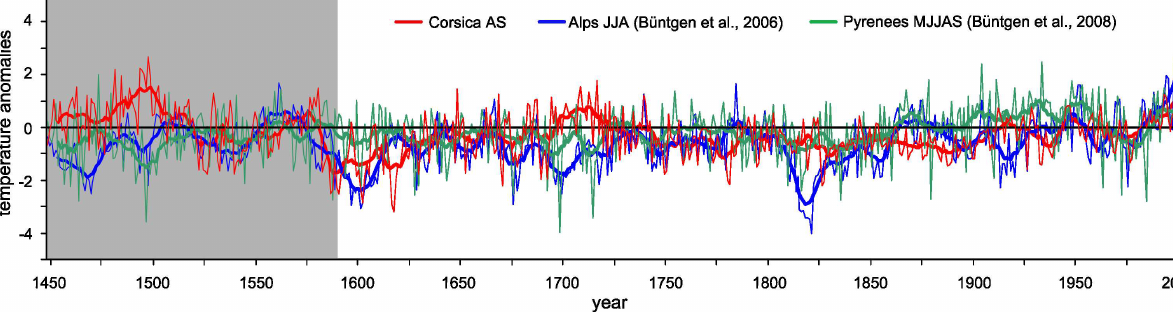
Fig. 6. Comparison of the August/September temperature reconstruction from Corsica (derived from Asinao C FE -chronology) with summer temperature reconstructions from the Alps (B´untgen et al., 2006) and Pyrenees (B¨untgen et al, 2008) (data available from NOAA Paleo- climatology Program: www.ndcc.gov/paleo/recons.html). Temperatures are expressed as anomalies. Reconstructions for the Alps and the Pyrenees are based on maximum latewood density series from Larix decidua and Pinus uncinata . Grey shaded area marks the part of the Corsican reconstruction where the pooled isotope chronology is based on less than 6